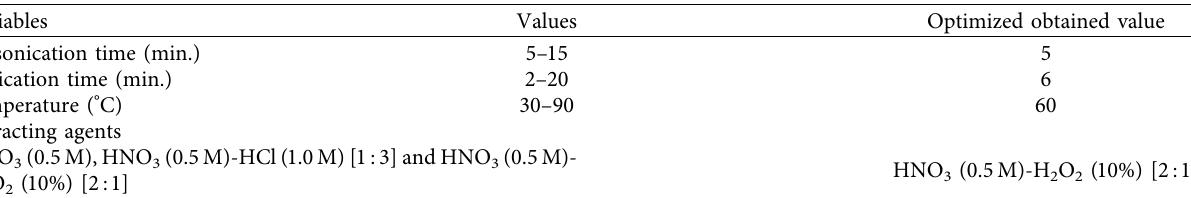
Table 5: Optimized conditions for extraction of micro- and macroelements in fruit peel powder by UAE method. Variables Values Optimized obtained value Presonication time